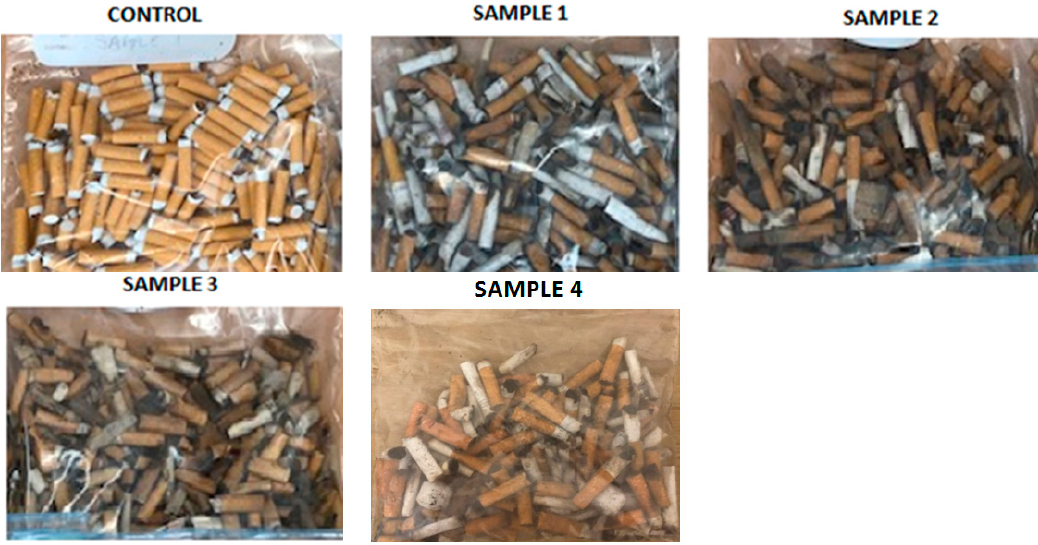
Figure 10. CB samples utilised for preliminary bacteriological study 2.